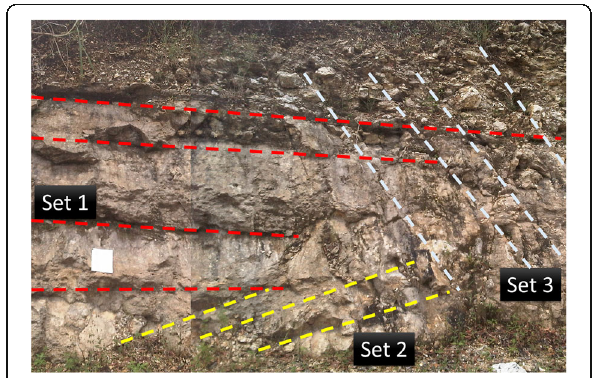
Fig. 2 Three sets of joints were measured in indirect RQD observations (without borehole). The picture was taken at Station 4 (110°20 ′ 53.25 ″ E, 8°0 ′ 15.08 ″ S) with an A4 paper as a scale